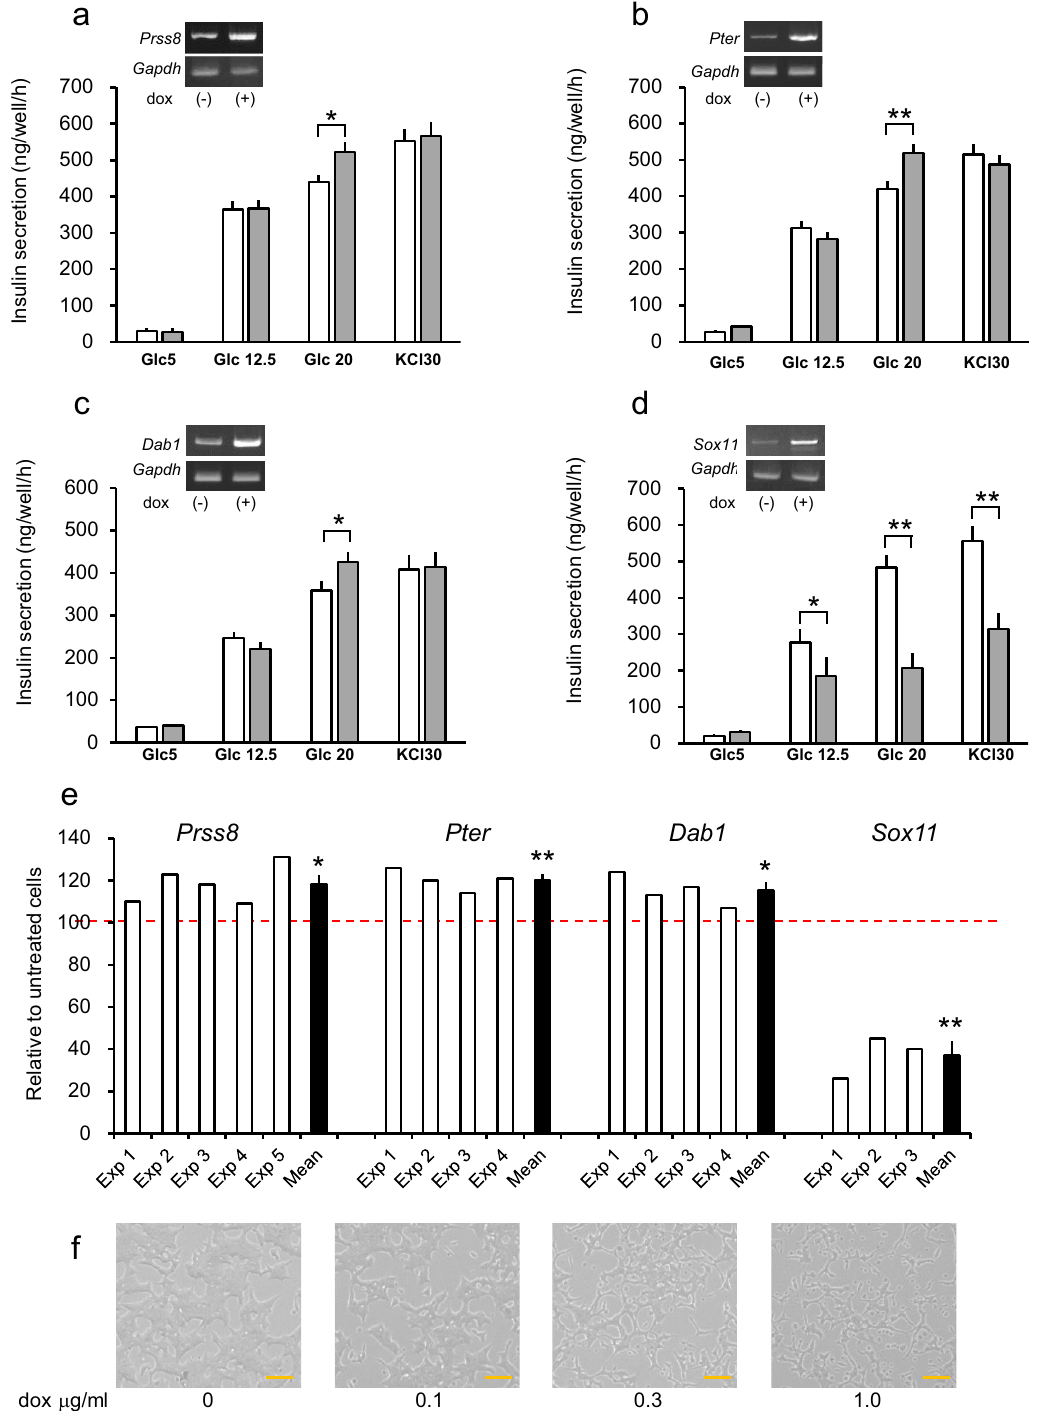
Figure 2. Examples of overexpression screening. ( a – d ) Effects on insulin secretion of the overexpressions of 4 genes ( a Prss8 ; b Pter ; c Dab1 ; d Sox11 ) differentially expressed in highly and poorly glucose-responsive MIN6 cells. Overexpressions were induced by treatment with dox for 2 days as shown in the inset for RT-PCR gel results. Insulin secretions from dox-treated and untreated cells are shown with grey and white bars, respectively. Graphs are representative individual experiments and data are means ± SE, n = 3 wells. * P < 0.05, ** P < 0.01, Student unpaired t test. Uncropped RT-PCR data are provided in Supplementary Fig. S2. ( e ) Summary of the insulin secretion results for 4 genes at 20 mM glucose. Amounts of secreted insulin are expressed as values relative to those from dox-untreated cells at 20 mM glucose, which is defined as 100 (dotted red line). Insulin secretion data at 20 mM glucose relative to those from untreated cells are presented for individual experiments (white bars) and for their averages (black bars, means ± SEM). Mean values are tested for significance from untreated cells using a one-sample t test. * P < 0.05, ** P < 0.01. ( f ) Effects on cell number of the Sox11 overexpression. Overexpression was induced by treatment with different concentrations of dox for 2 days. Bars 100